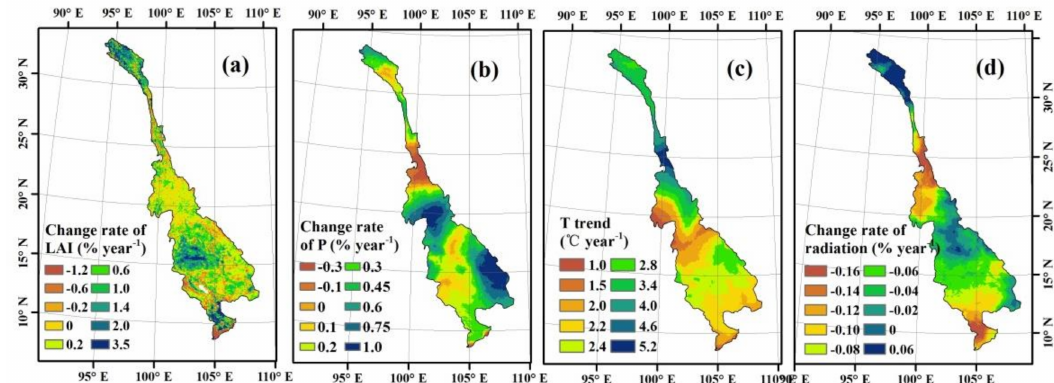
Figure A1. Spatial patterns of the temporal variations of the annual ( a ) leaf area index (LAI), ( b ) precipitation, ( c ) temperature and ( d ) radiation from 1981 to